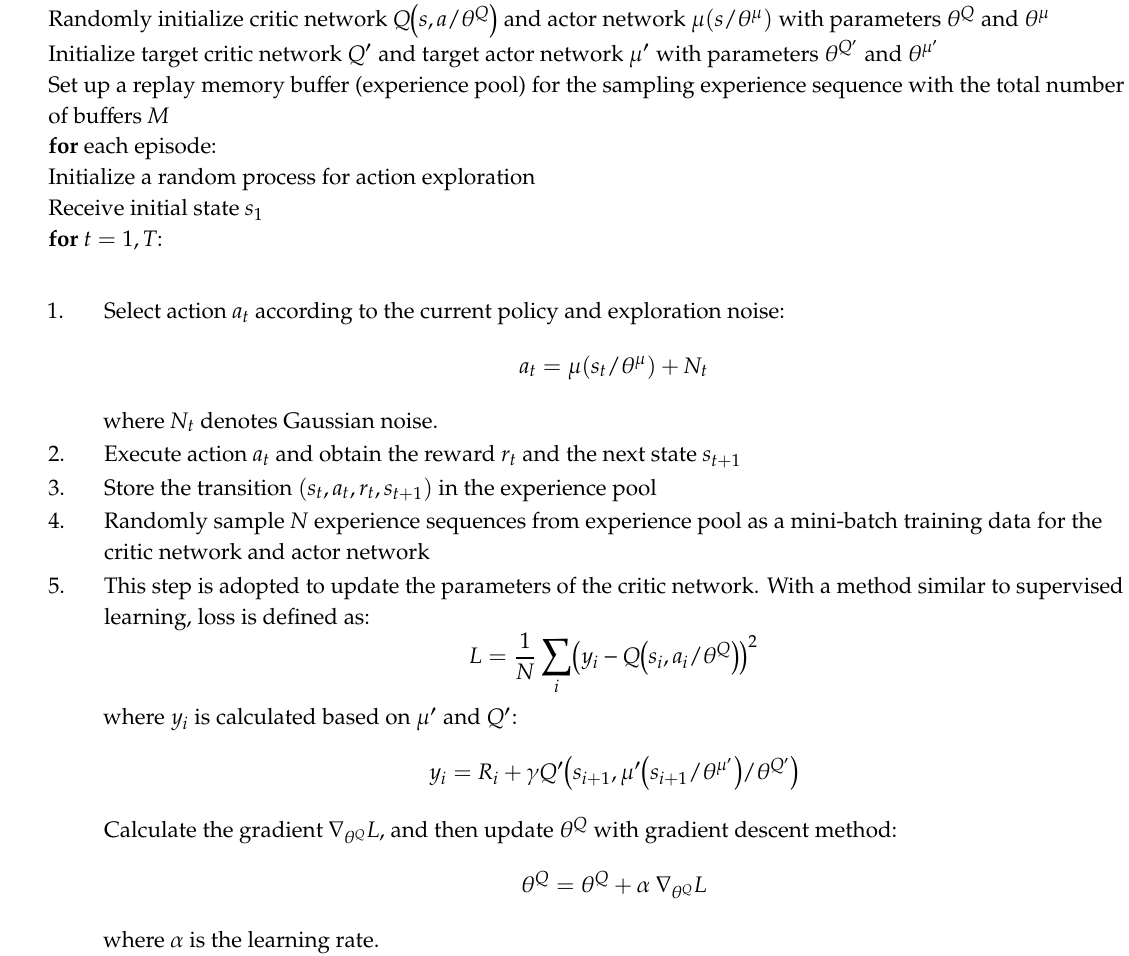
Algorithm 1: DDPG